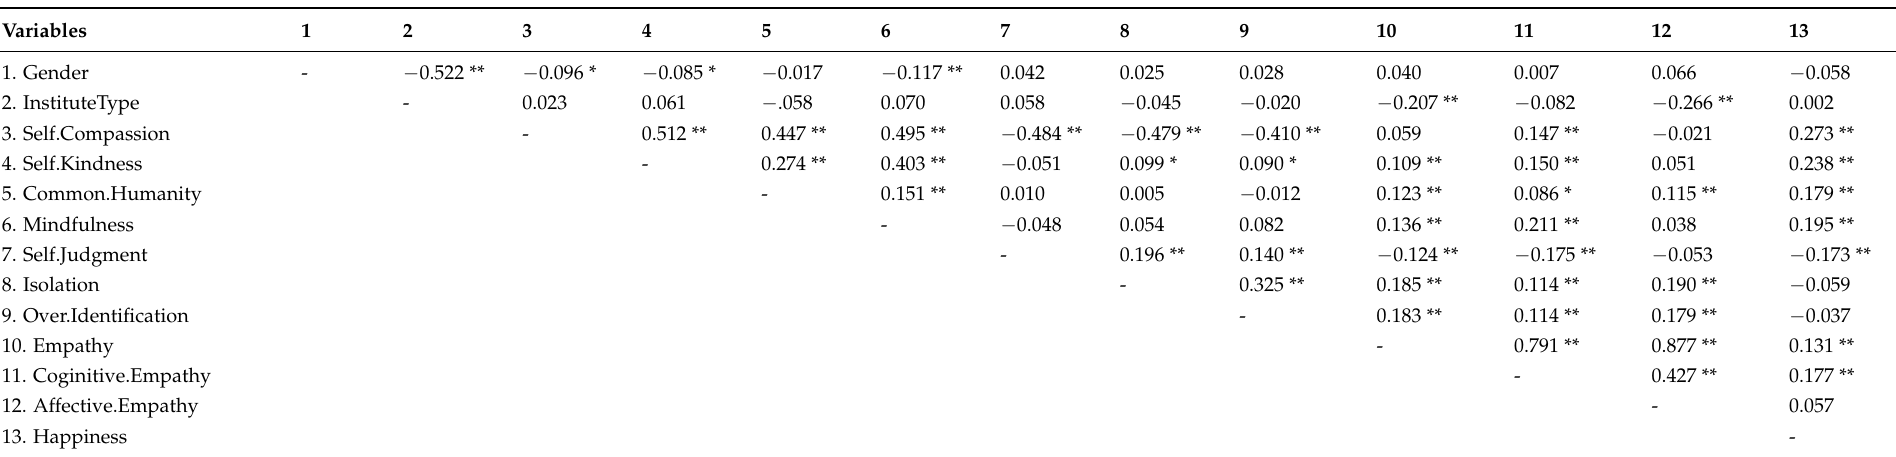
Table 1. Relationship between self-compassion, empathy, happiness, gender, and institute type of late adolescents ( N =